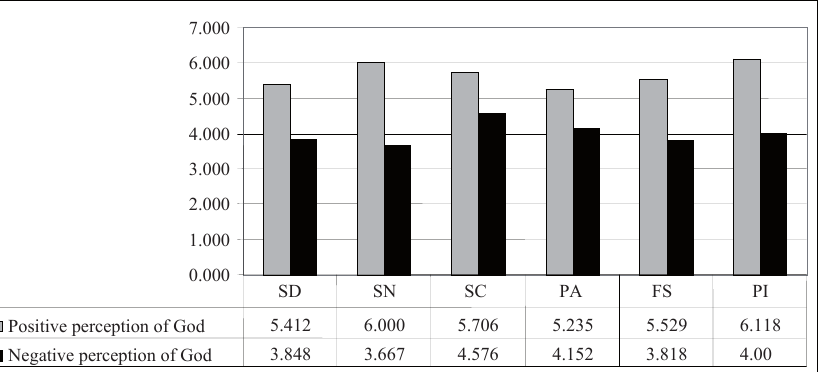
Fig. 2. Figures of statistically signi fi cant means based on the results of a morphological test of life values for believers with different perceptions of God at р <0,05; note: SD – self-development, SN – spiritual needs, SC – social contacts, PA – personal achieve- ments, FS – fi nancial standing, PI – preservation of own